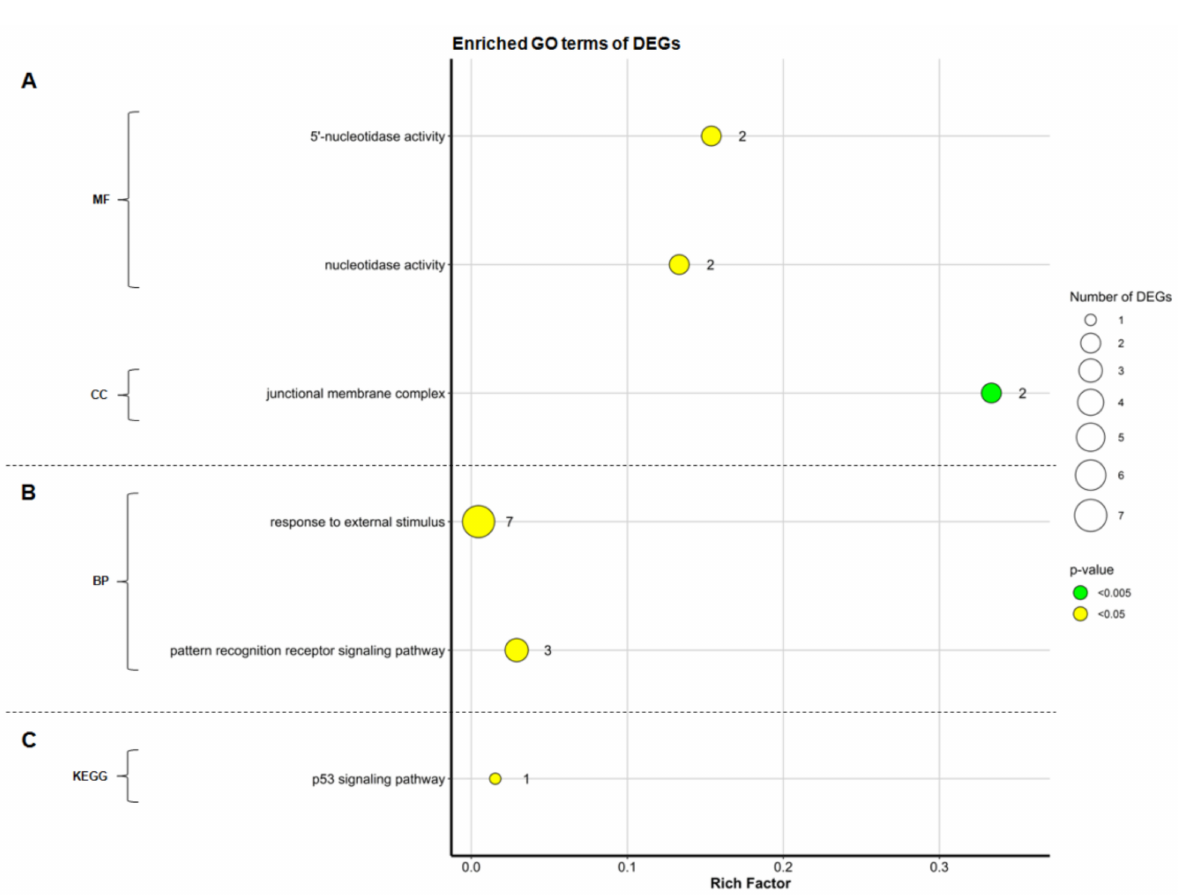
Figure 4. Gene ontology (GO) enrichment and KEGG pathway analysis based on differentially expressed genes (DEGs between ascarid-infected Lohmann Dual (LD) and Lohmann Brown Plus (LB) hens. Panel ( A ) shows enriched GO terms derived from upregulated DEGs in LD hens without (I) or with (III) regard to infection intensity*; Panel ( B ) represents upregulated DEGs in LB hens (I); Panel ( C ) represents the result of KEGG pathway analysis derived from upregulated DEGs in LB hens without (I) and with (III) regard to infection intensity *. The vertical axis represents the enriched GO terms, and the horizontal axis represents the affiliated rich factor (ratio of the number of DEGs associated with the GO term to the total number of genes associated with the GO/KEGG term). The size and colour of dots represent the number of DEGs and the range of adjusted p -values (after Bonferroni correction), respectively. MF: molecular function; CC: cellular component; BP: biological process; *: DEGs identified in comparisons I and III resulted in the same GO